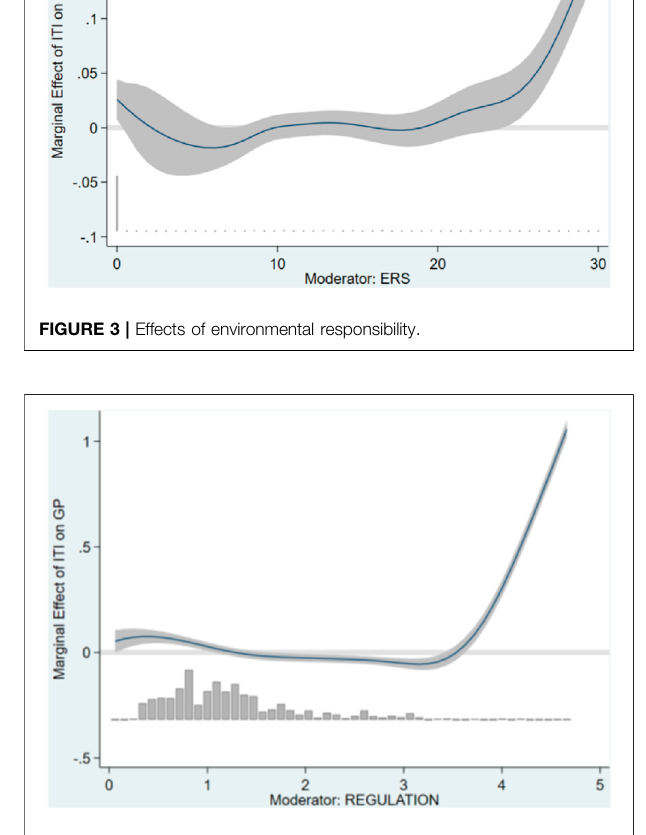
FIGURE 4 | Effects of environmental